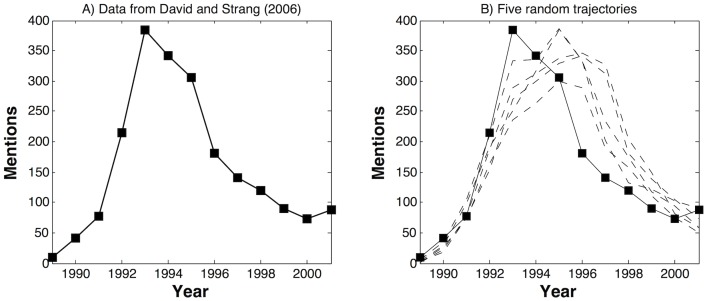
David and Strang (2006)’s data: Comparison of the observed data and the predicted values from Poisson models using parameters from Table 2.